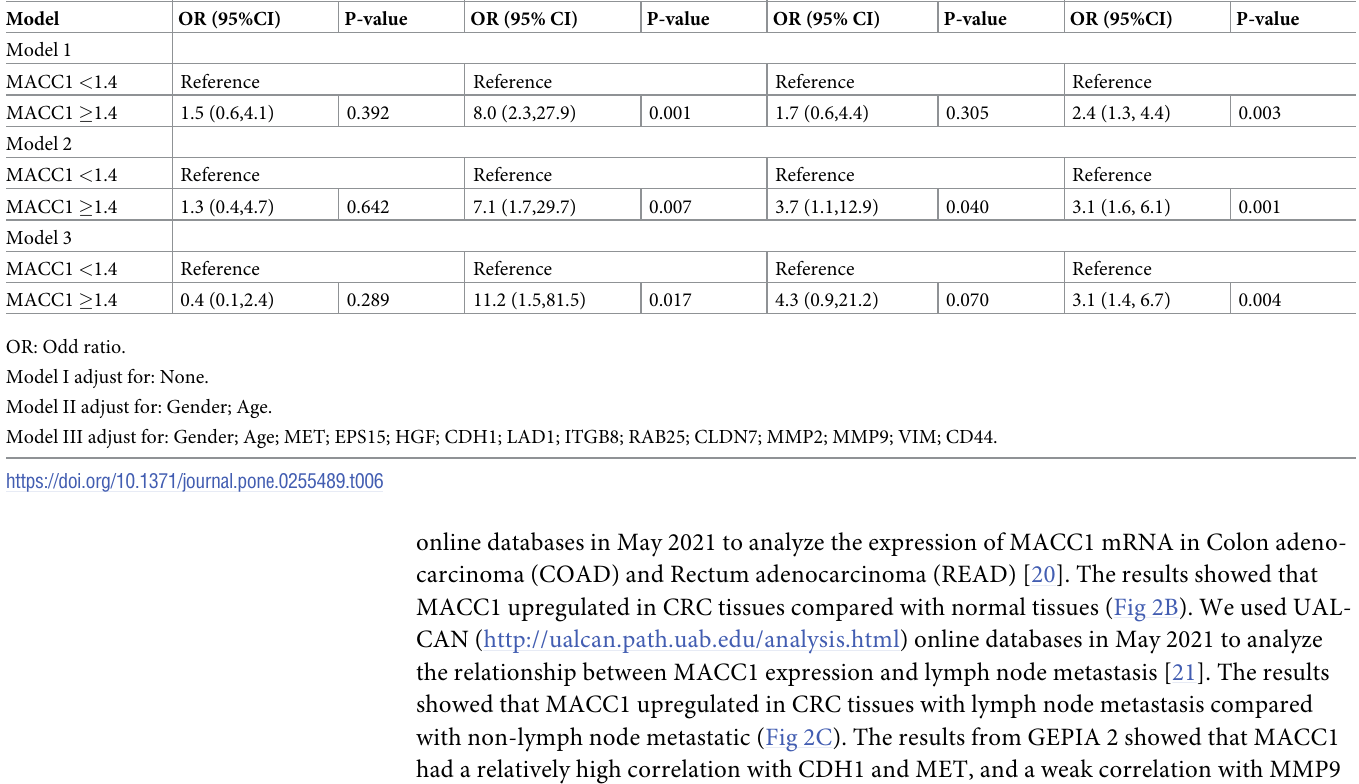
Table 6. Threshold effect analysis of MACC1 expression on lymphatic metastasis (N =